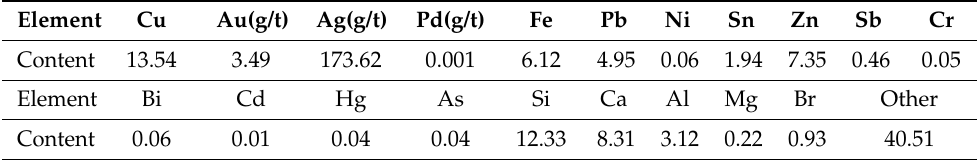
Table 4. Chemical composition of the bag filter dust, wt.%.